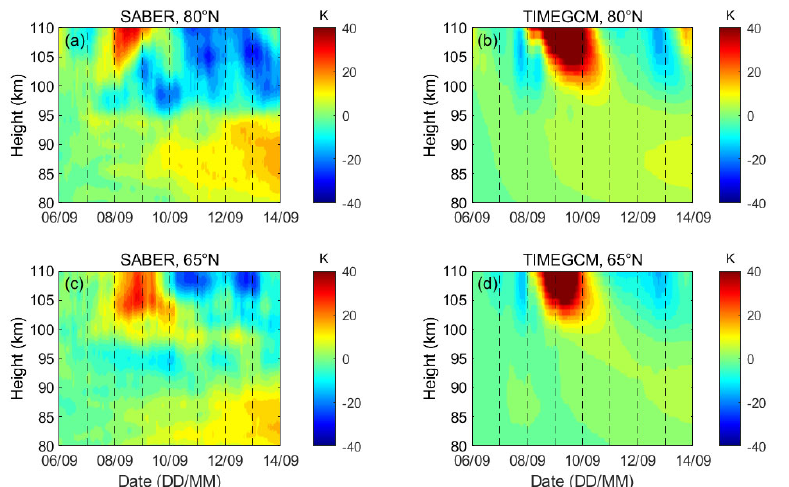
Figure 2. The storm time variations of the zonal running temperature from SABER (left column) and TIMEGCM (right column) within a 5° latitude band in the altitude range of 80–110 km during 6–13 September 2017. The latitudes are 80° N (top row) and 65° N (bottom row) for both SABER and TIMEGCM. The color bar scale ranges from -40 K to 40 K. The x -axis represents the date on 2017; for example, 06/09 means September 6, 2017. The y -axis represents the heights. The black vertical dotted lines point to the 00:00 UT of the date marked on the x ‐ axis.